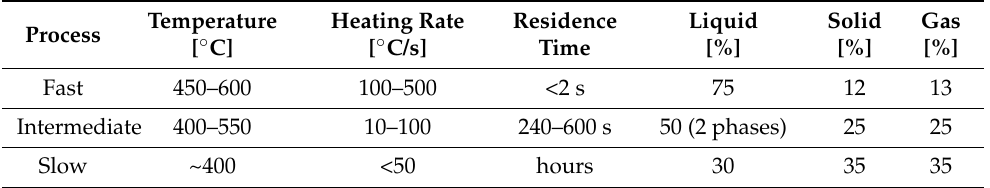
Table 1. Classification of pyrolysis processes (woody feedstock)